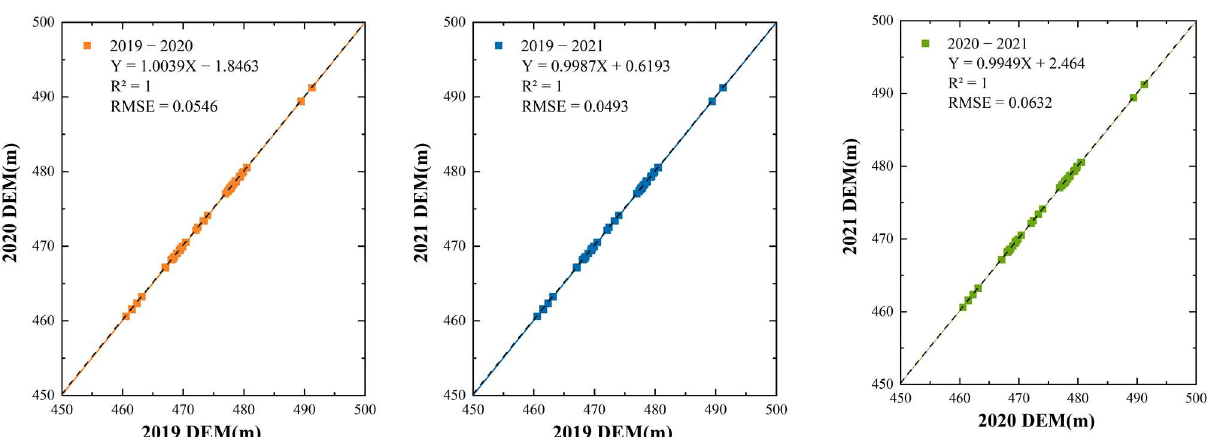
Figure 4. Fitting effect of DEM from different temporal UAV images. Two kinds of data are used to extract tree height. The first is elevation data based on DSM. This method directly extracts the elevation information of the open ground from the high-precision image. The second is the CHM established by processed DEM. First,